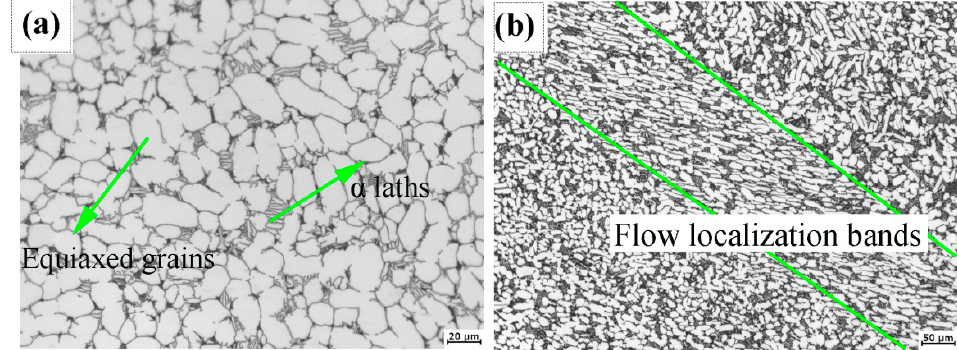
Figure 2. Microstructural characteristics of the Ti6242S alloy billet: ( a ) 500 times magnification, α p and α s phases indicated by green arrows; ( b ) 200 times magnification; the flow localization band (boxed by two green lines).